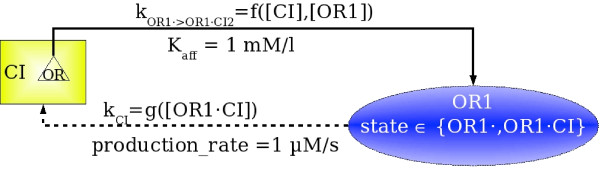
The same MIN model as the one used for genetic regulation modeling, enriched with complementary information allowing the translation into differential equations.